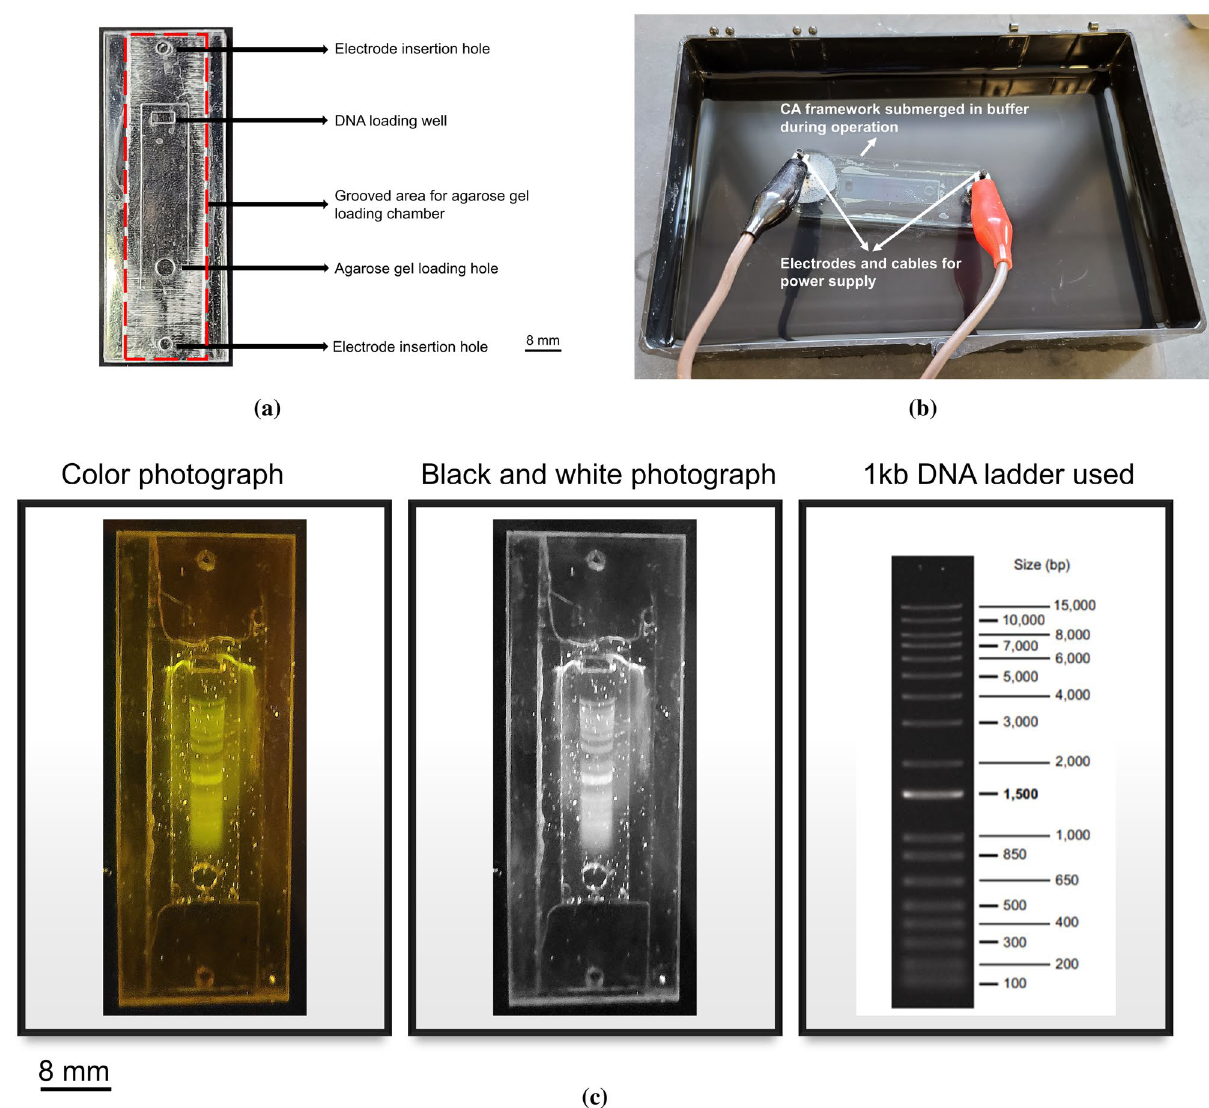
Figure 5. ( a ) Photograph of bonded CA framework for electrophoresis operation. ( b ) Electrophoresis setup in operation with bonded CA device with pencil lead electrodes and cables. ( c ) (Left two photographs) Black and white and color photograph after electrophoresis operation using 1 Kb DNA via an e-gel safe imager. (Right) Standard 1 Kb DNA ladder. Image from: https:// www. goldb io. com/ produ ct/ 14/1- kb- dna-